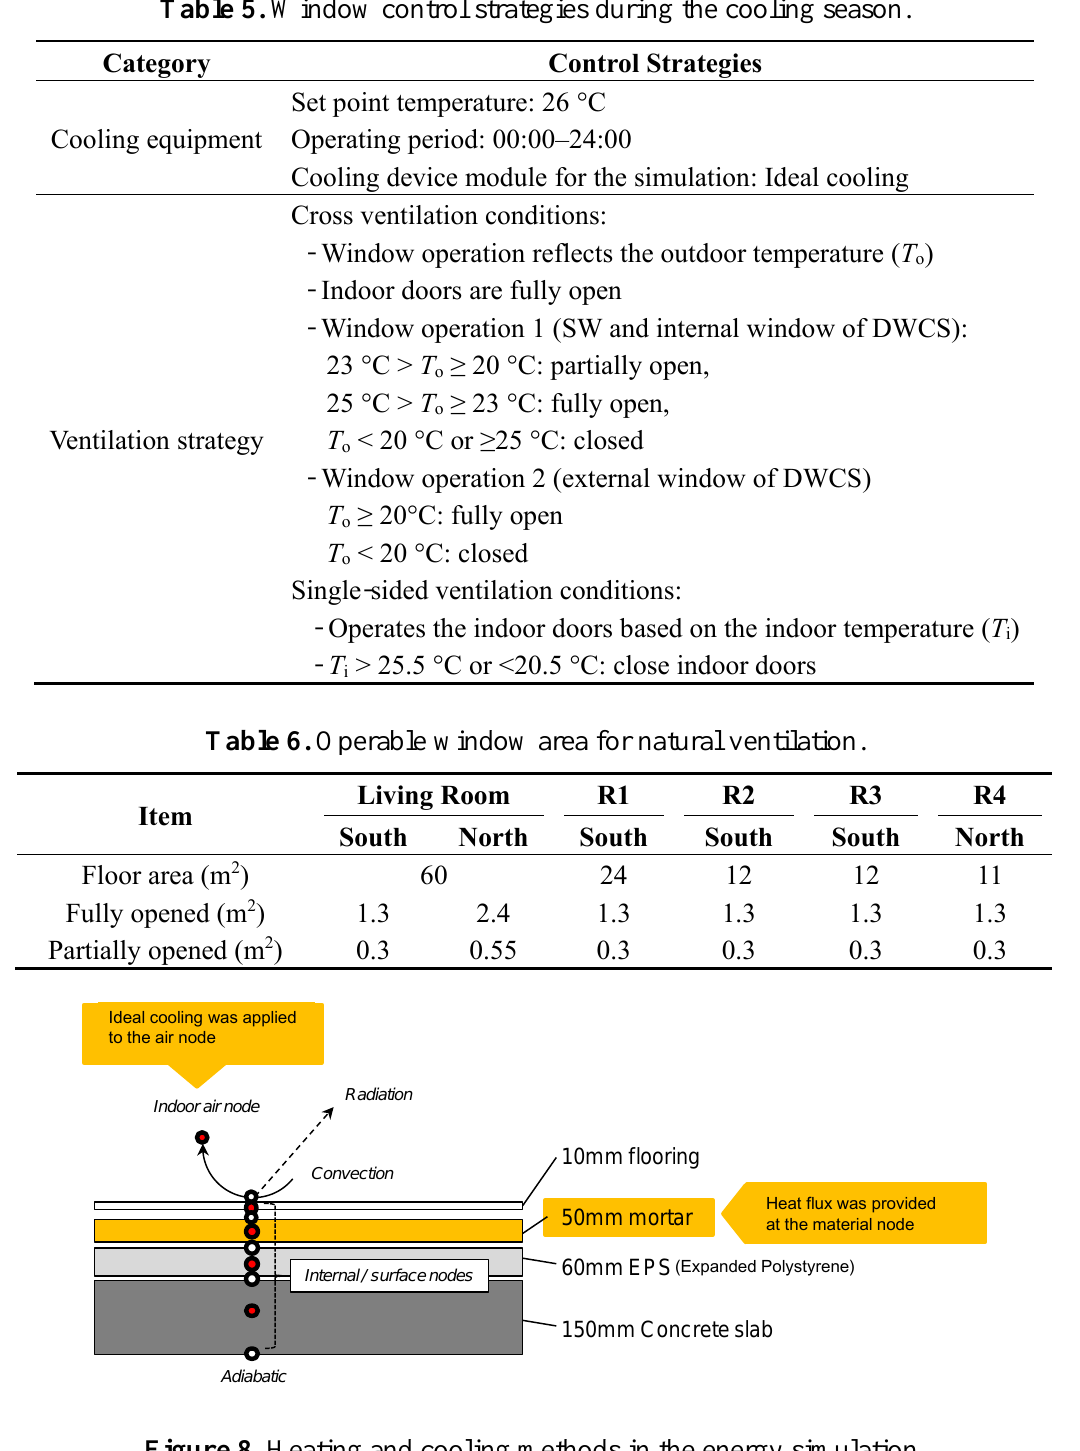
Figure 8. Heating and cooling methods in the energy